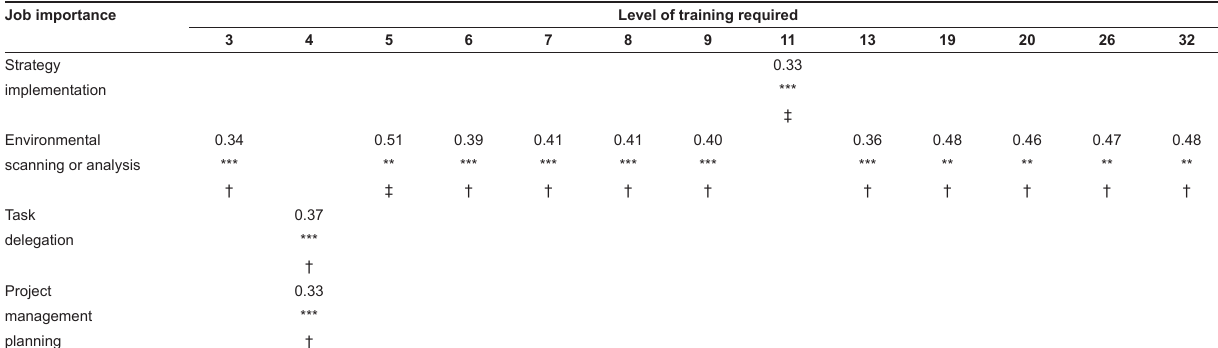
Pearson product-moment correlations: Competencies relating to planning and organising